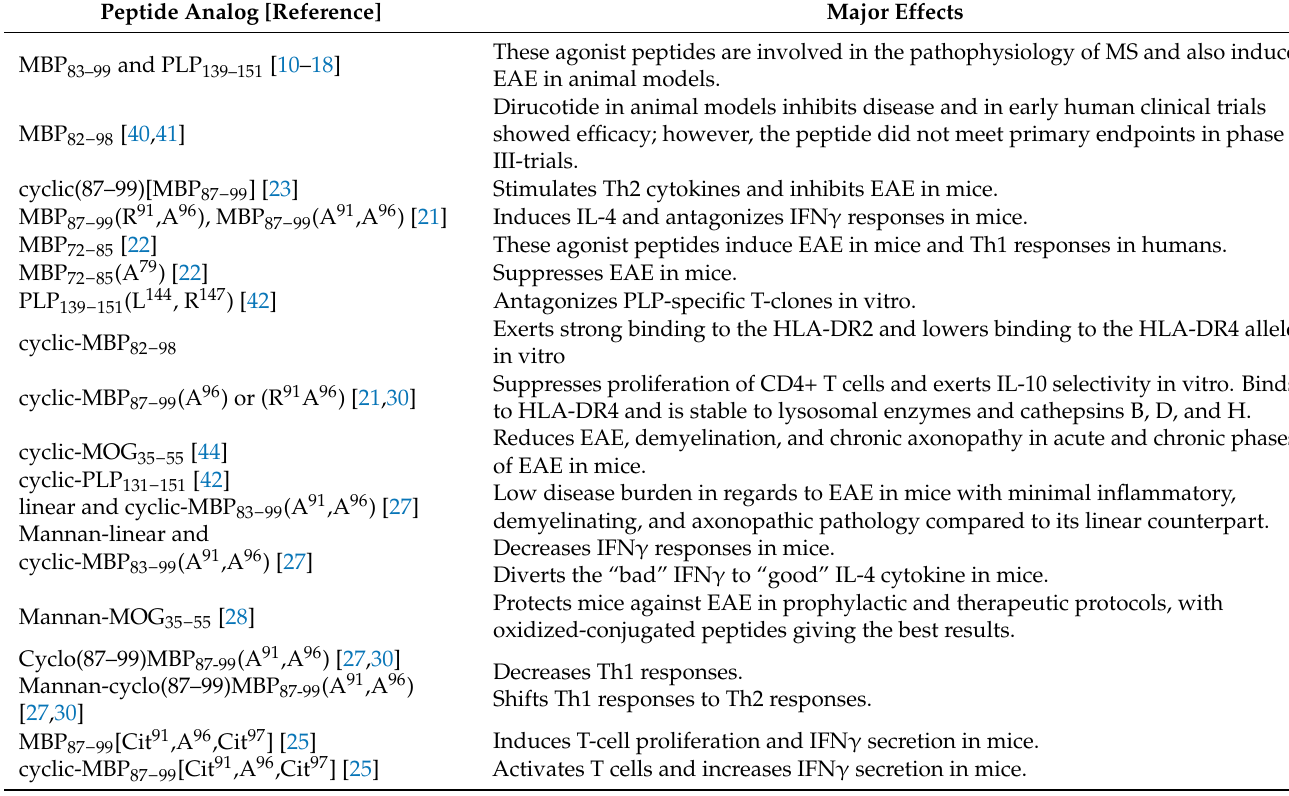
Table 1. Biological effects of myelin-derived peptides (linear, cyclic, mannan